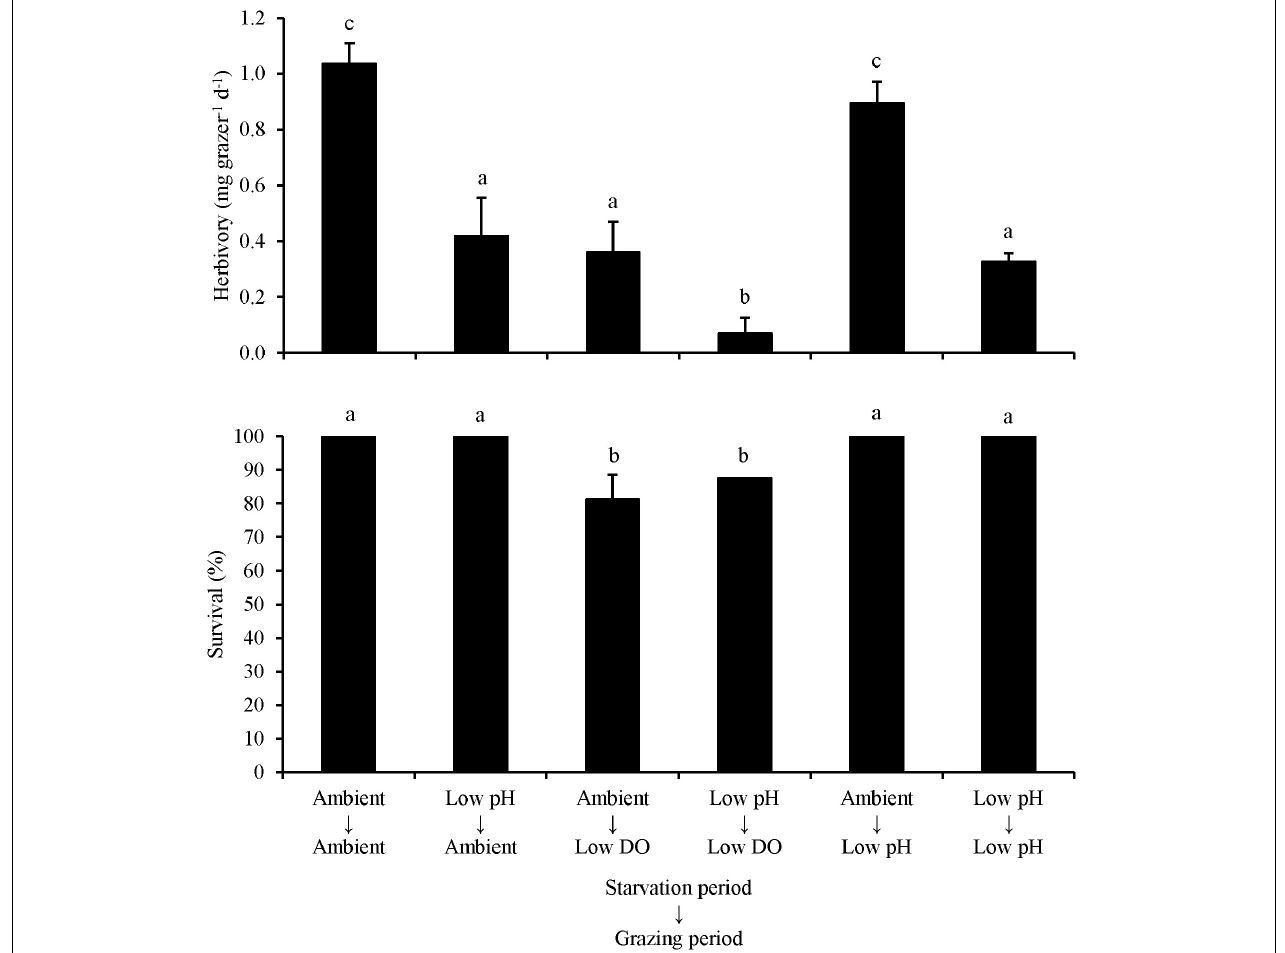
FIGURE 4 | Herbivory rates and survival of L. vincta grazing on U . rigida starved under ambient or low pH and allowed to graze on U. rigida under ambient, low dissolved oxygen, or low pH conditions (Experiment 4; Table 2 ). Columns represent means ± standard deviation. Statistical analyses: Two-way ANOVA and post hoc Tukey Honest Significant Difference tests performed; significant differences between treatments represent p -values less than